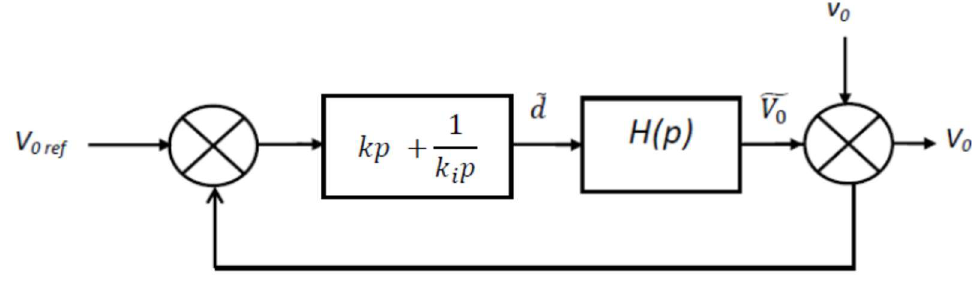
Figure 20. Control voltage.